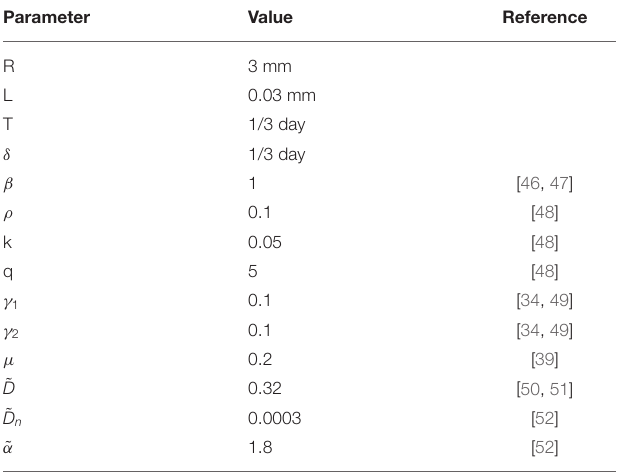
TABLE 1 | The values of parameters used in numerical